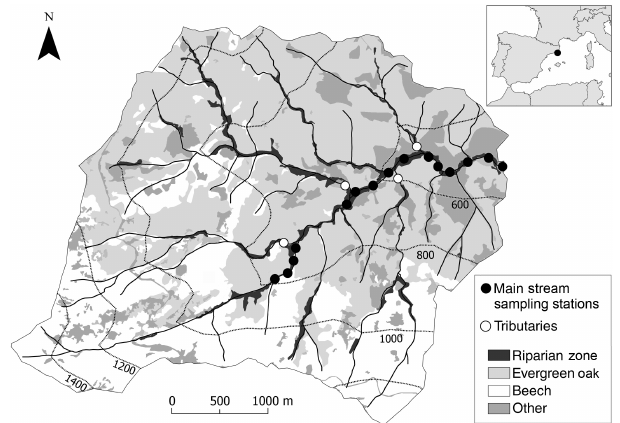
Figure 1. Map of the Font del Regàs catchment within the Montseny Natural Park (northeastern Spain). The vegetation cover and the main stream sampling stations along the 3.7km reach are indicated. Four permanent tributaries discharged to the main stream from the upstream- to the downstream-most site (white circles). The remaining tributaries were dry during the study